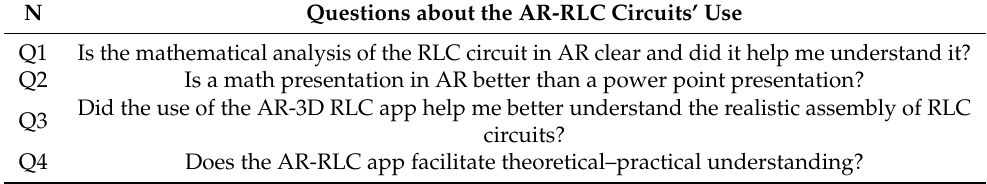
Table 4. Survey on the use of the AR-RLC circuits.